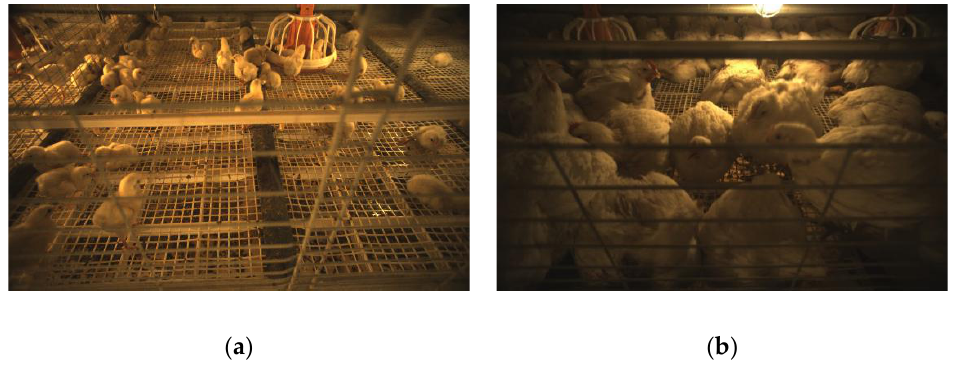
Figure 8. Broiler flocks in 6 days old ( a ) and 36 days old ( b ).